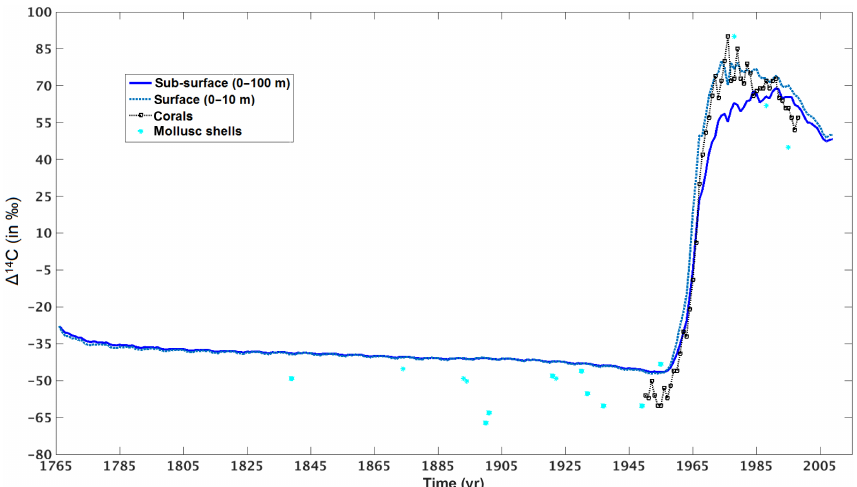
Figure 6. (cid:49) 14 C values (in‰) in the Ligurian sub-basin from 1765 to 2008 for the surface water (0–10m depth; blue dashed line) and sub- surface water (0–100m depth; blue solid line) together with available in situ observations (Tisnérat-Laborde et al., 2013) from coral (black dashed line) and molluscs (cyan stars).